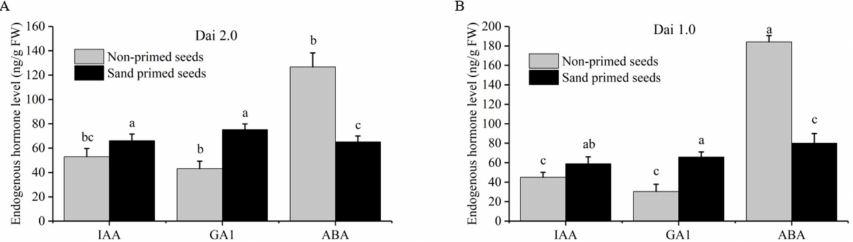
Figure 2. Effects of sand priming on the content of endogenous phytohormone of Pinus massoniana . ( A ) The result of Masson pine variety “Dai 2.0”. ( B ) The result of Masson pine variety “Dai 1.0”. IAA: indole-3-acetic acid; ABA: abscisic acid; GA 1 : gibberellin A1. Lower-cased letters indicate statistically significant differences ( p < 0.05, Duncan multiple range